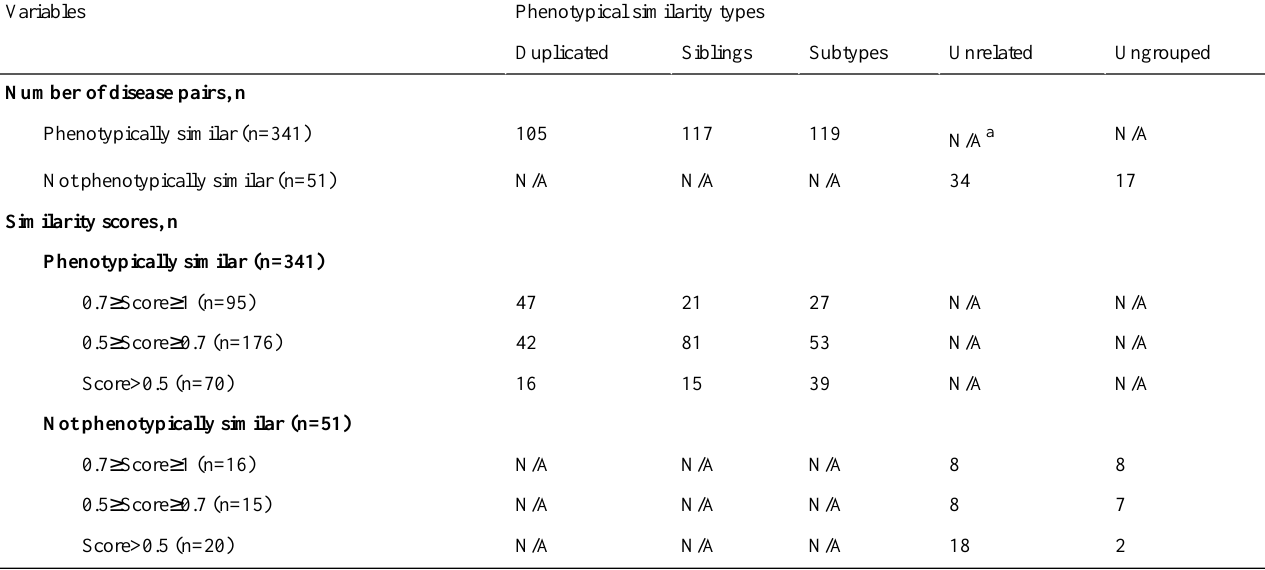
Table 4. Manual review results for the disease pairs (n=392); precision=94%, recall=79%, F